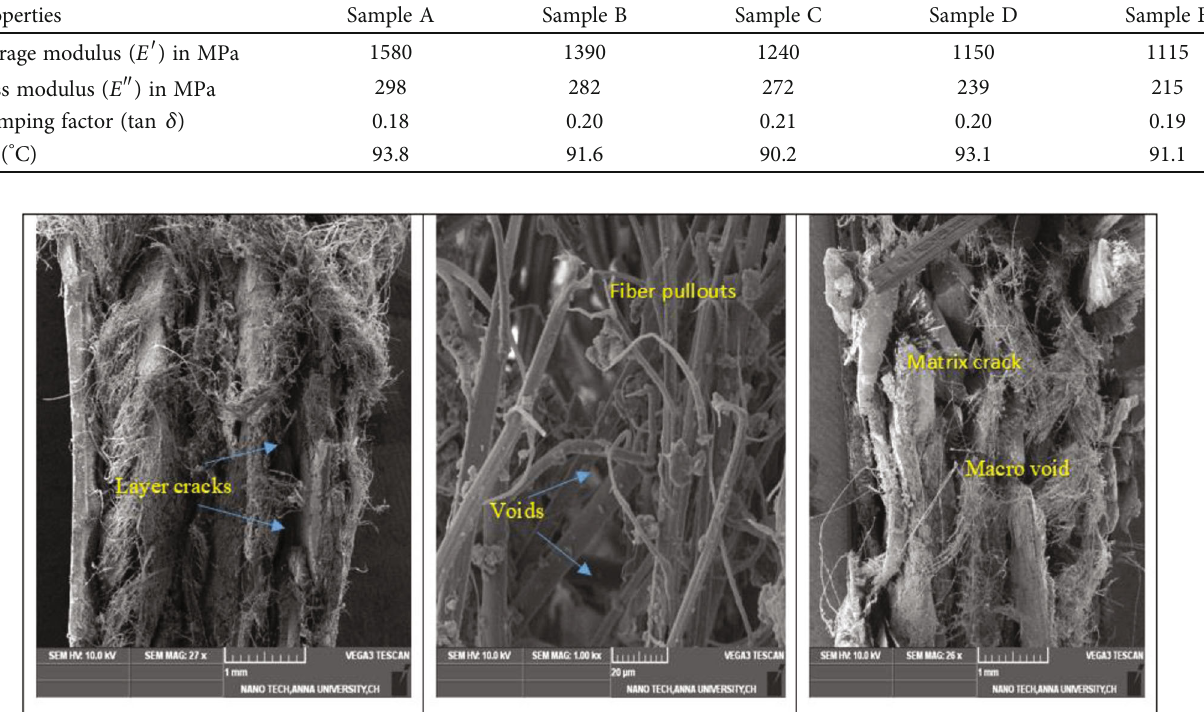
Figure 7: SEM image of hybrid